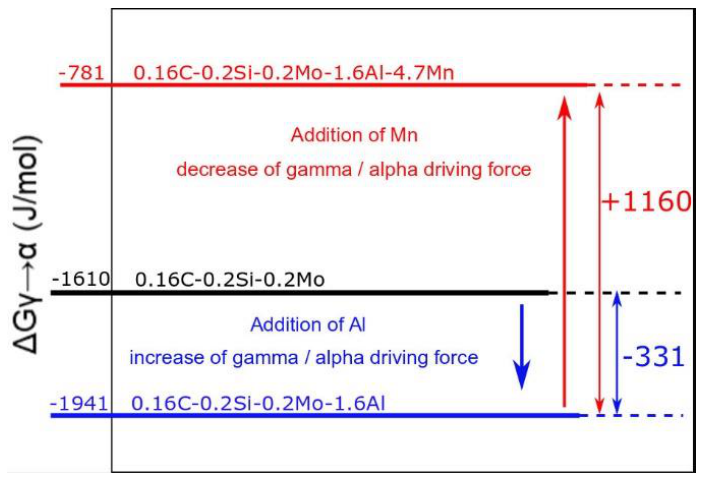
ff ects on a driving force at 400 ◦ C